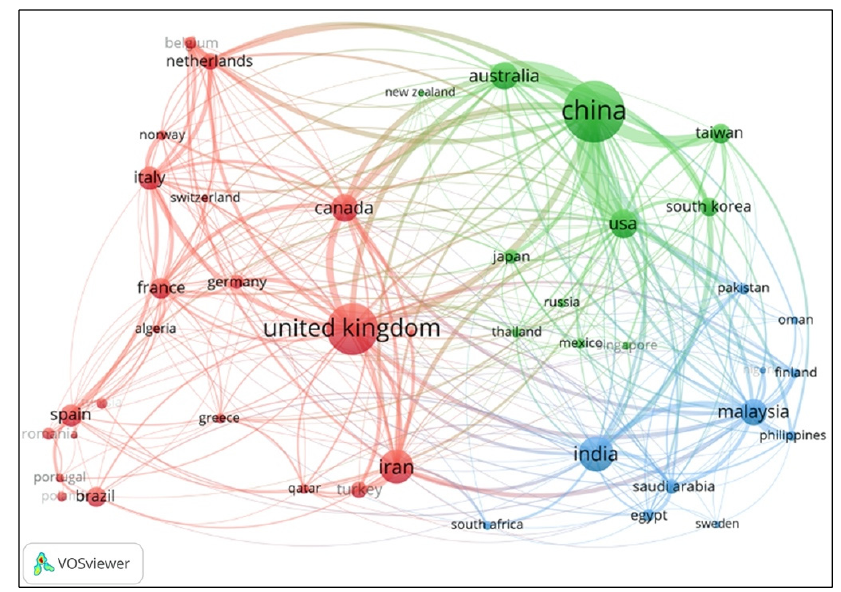
Figure 4. Countries/regions collaboration network in PSEP publications.